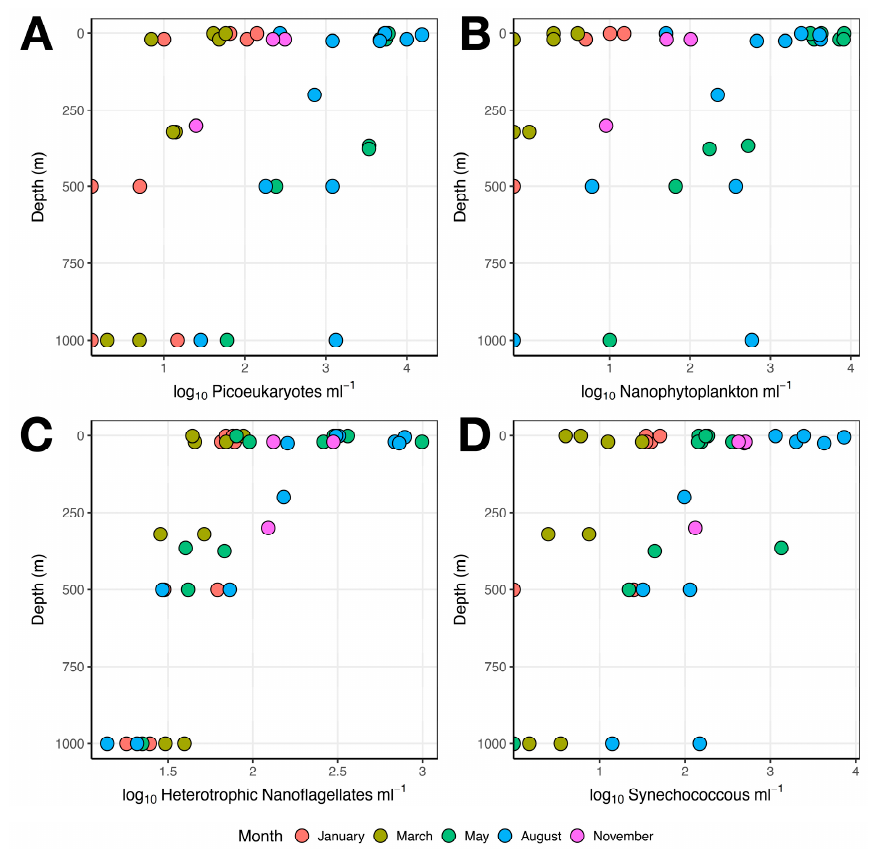
Figure 2. Scatterplot showing abundances of key eukaryotic microbial populations as determined by flow cytometric enumeration. ( A ) Pico, ( B ) nano, ( C ), HNF, and ( D ) cyanobacteria. Depth (m) is shown on the y axis. Sampling months are represented with different colors. Note logarithmic x axis.